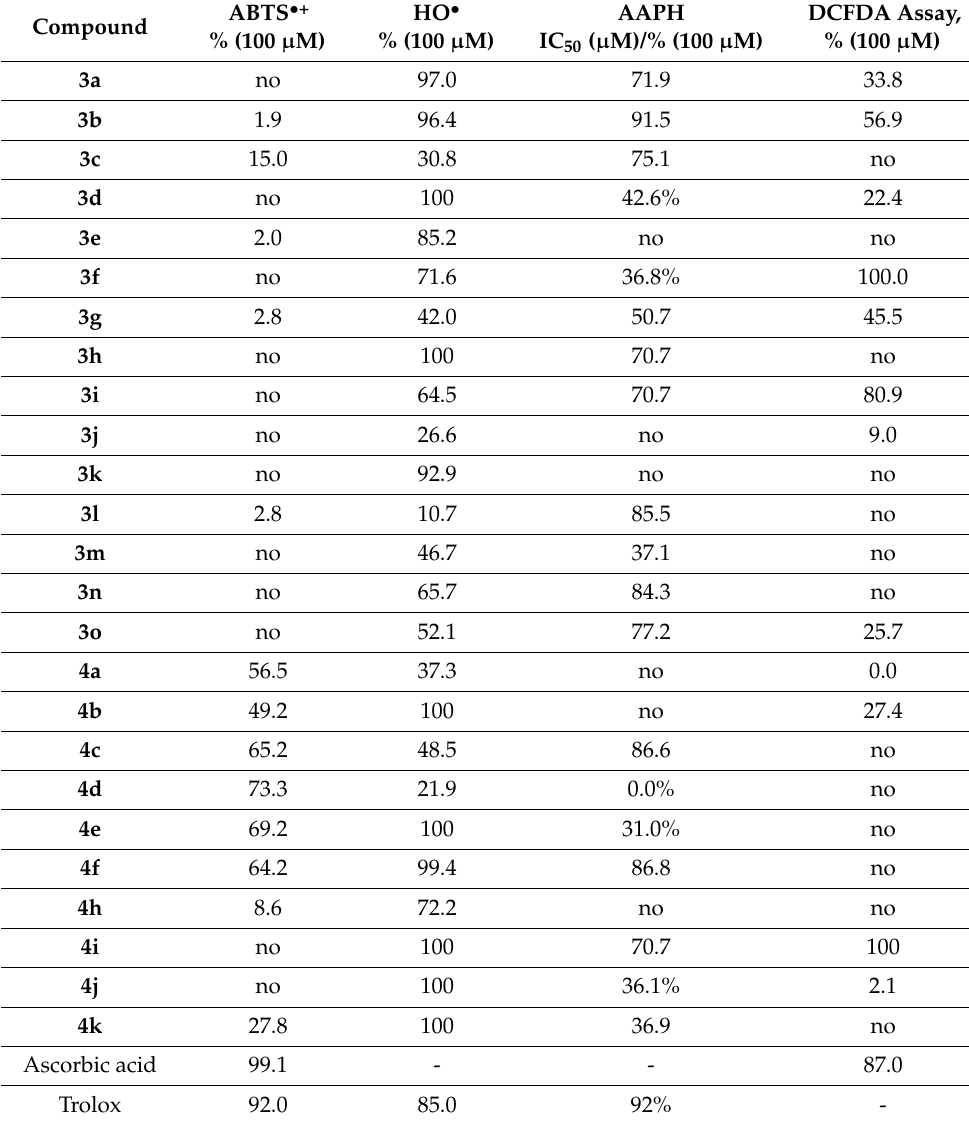
Table 2. In vitro antioxidant evaluation of the synthesized compounds, through the (i) ABTS assay, (ii) the competition with DMSO for hydroxyl radical (HO • ) scavenging ability, (iii) the inhibition of linoleic acid induced by AAPH assay *, and (iv) the DCFDA assay #,$ .